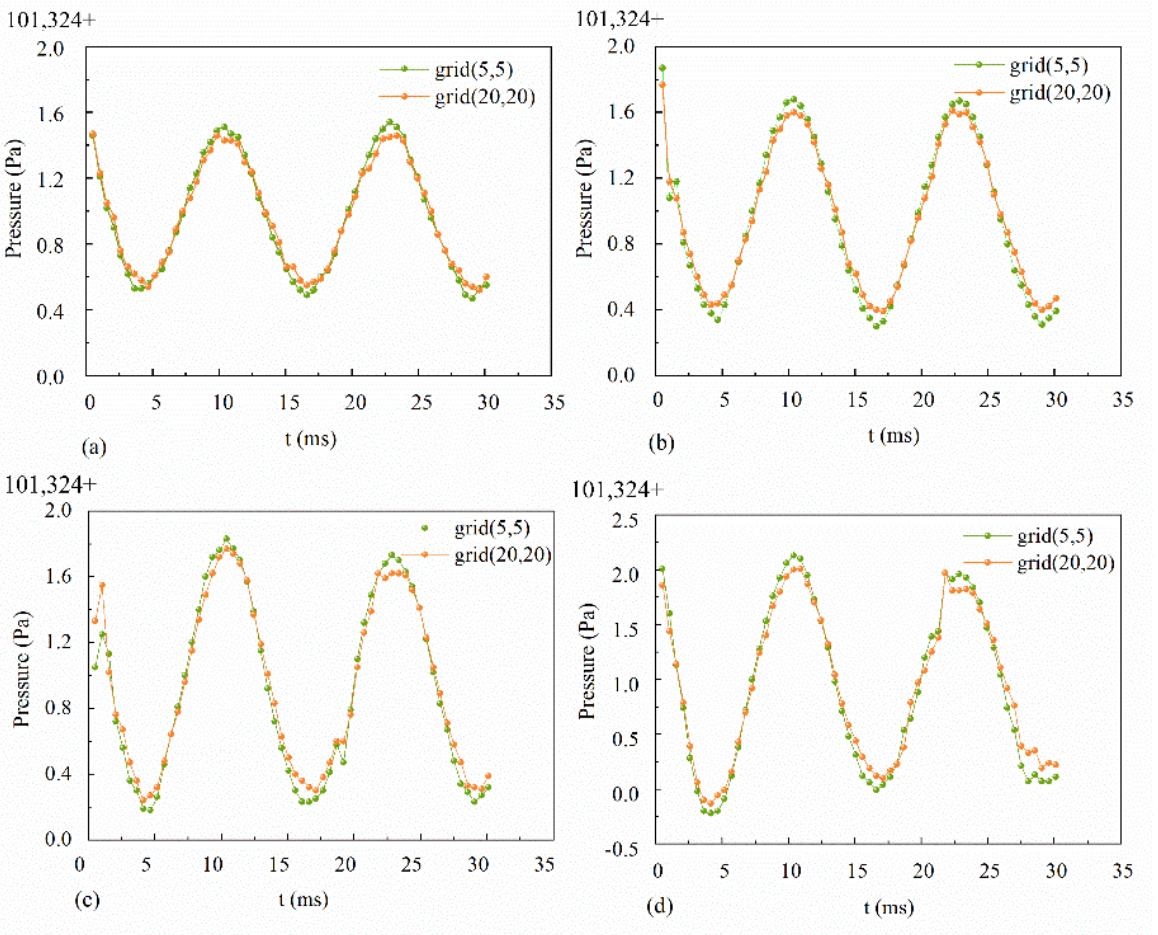
Figure 5. Variation in the fluid pressure in grid (5, 5) and grid (20, 20) with the vibration frequency of 80 Hz for particle size of ( a ) 60 µ m, ( b ) 80 µ m, ( c ) 100 µ m, and ( d ) 150 µ